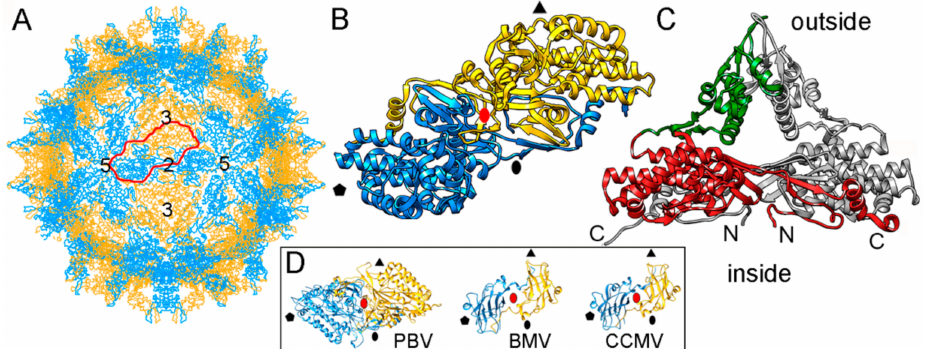
Figure 4. PsV-F T = 1 capsid protein X-ray-based structure. ( A ) T = 1 capsid of PsV-F viewed along a two-fold axis of icosahedral symmetry, showing the CP subunits A (blue) and B (yellow), with the boundaries of an asymmetric unit (a quasi-symmetric A-B dimer) outlined in red. Numbers indicate icosahedral symmetry axes. ( B ) Top view of the atomic model of a PsV-F CP dimer (3es5; 420 residues). Symbols indicate icosahedral symmetry axes; red oval indicates a local two-fold symmetry axis. ( C ) Side view of a PsV-F CP dimer. The arch (green) and shell domains (red) are indicated. For clarity, the second subunit is shown in grey. ( D ) T = 1 CP dimers of PBV (2vf1), BMV, brome mosaic virus (1js9), and cowpea chlorotic mottle virus (CCMV; 1cwp). Dimers are related by a local quasi-two-fold symmetry axis (red oval), and show molecular swapping. BMV and CCMV are plant ssRNA viruses with T = 3 capsids, but their CP (with a β -barrel domain) can assemble into 120-subunit capsids that show a quaternary organization similar to that of PsV-F and